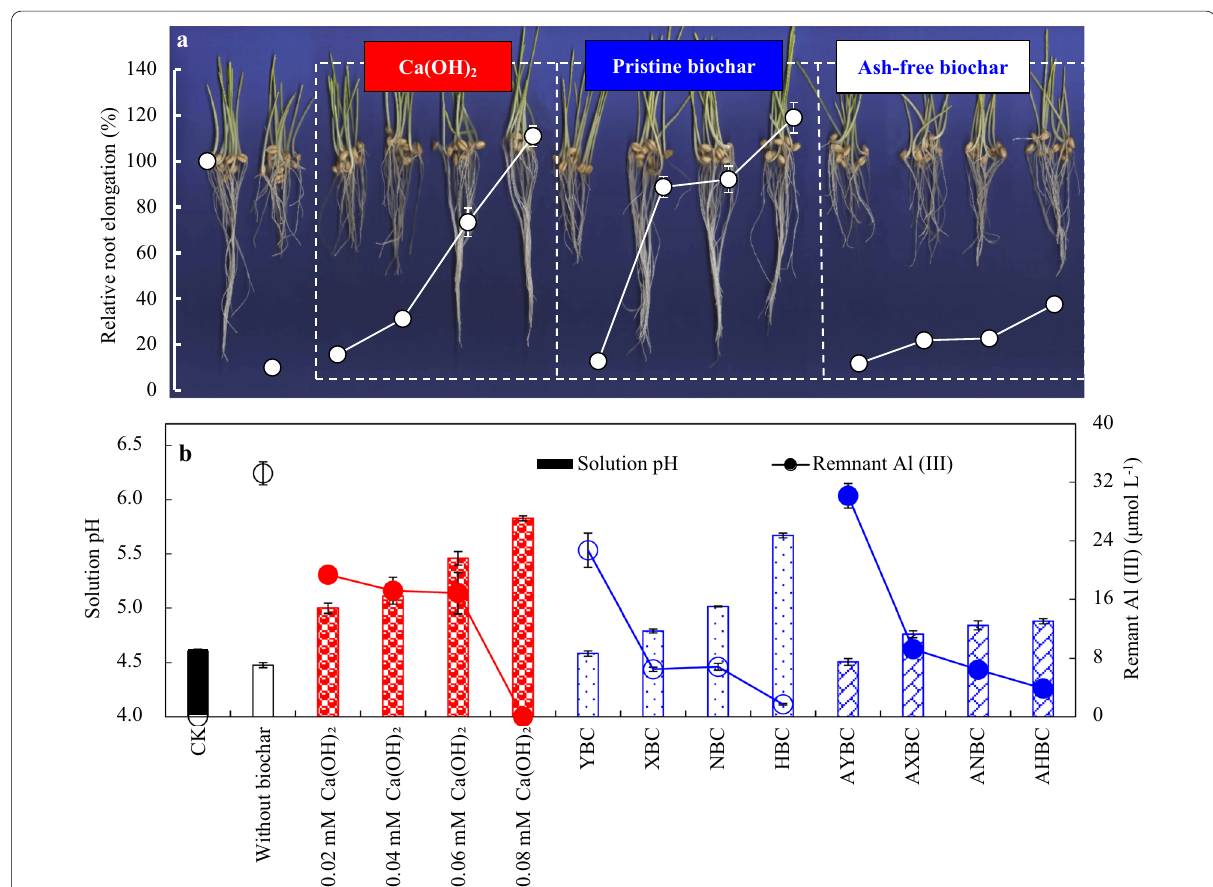
Fig. 3 Root elongation of wheat seedlings in the following treatments of CK, without biochar, and different dose of Ca(OH) 2 , pristine and ash-free biochar amendment after 48 h of Al(III) exposure ( A ). The pH values and remnant Al(III) in the stress solutions of wheat seedling roots subjected to 48 h Al(III) exposure ( B ). The treatments of CK and without biochar represented without Al(III) and amendments, and without biochar but with Al(III) addition, respectively